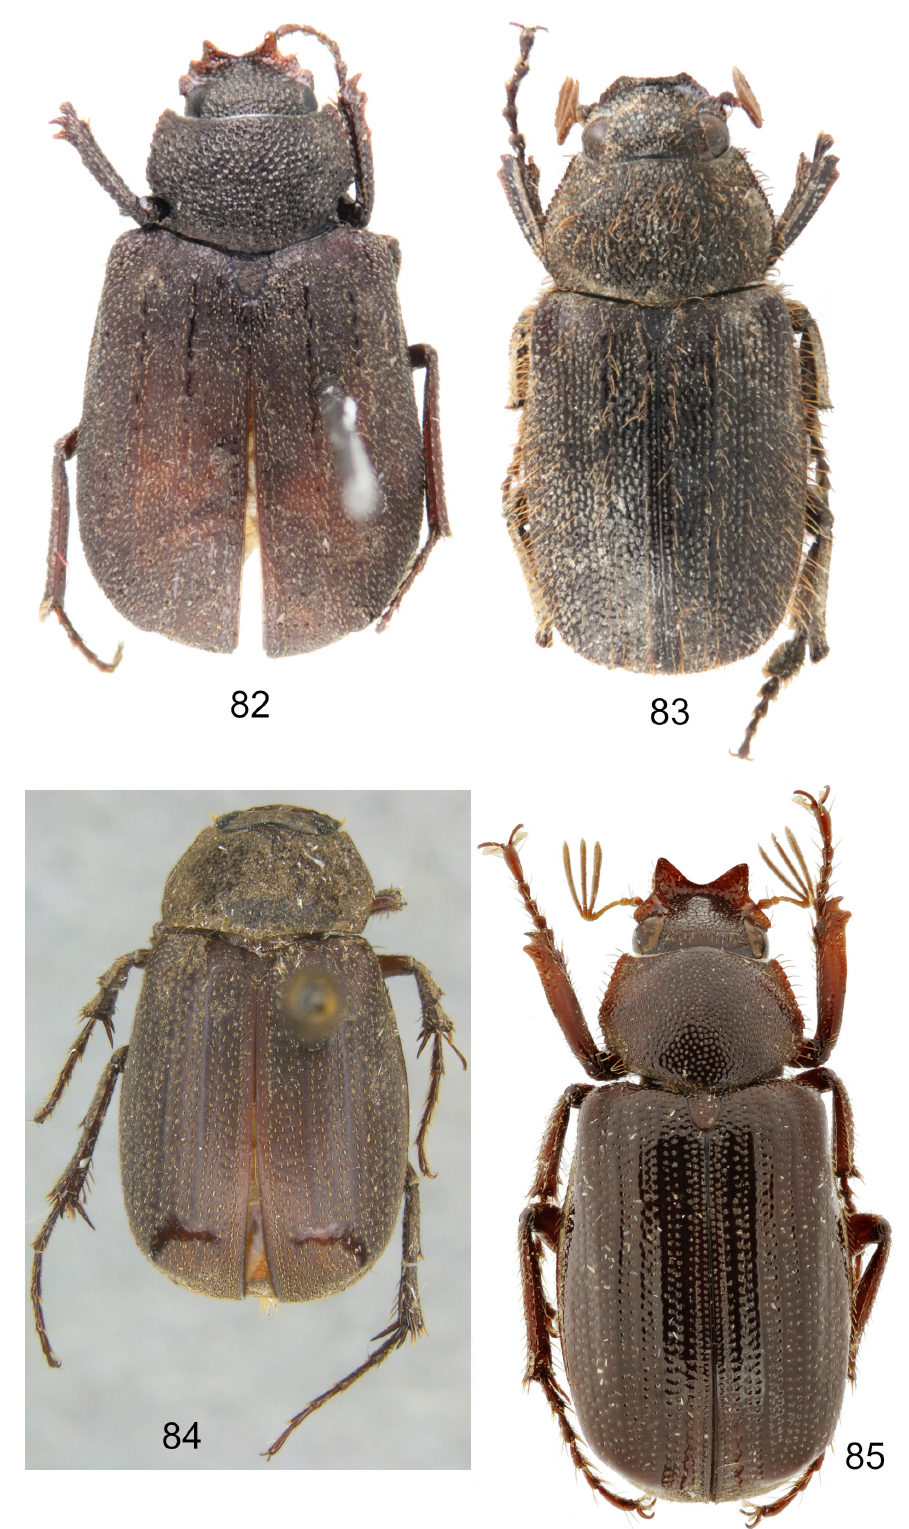
Figs 82–85. Papuan and Wallacean Maechidius Macleay, 1819, habitus, dorsal view. 82 . M. similis sp. nov., paratype, ♂ (BMNH). 83 . M. skalei sp. nov., paratype, ♂ (NME). 84 . M. simplex Frey, 1969, holotype, ♂ (photograph courtesy BPBM) (BPBM). 85 . M. sougb sp. nov., holotype, ♂ (NME). Not to